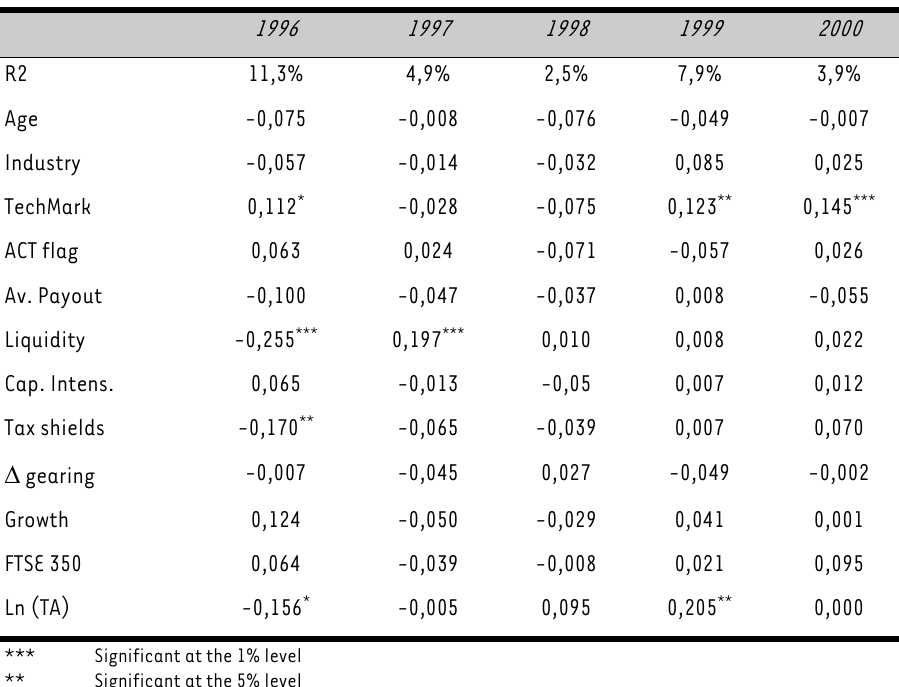
TABLE 6: Regression of changes in institutional